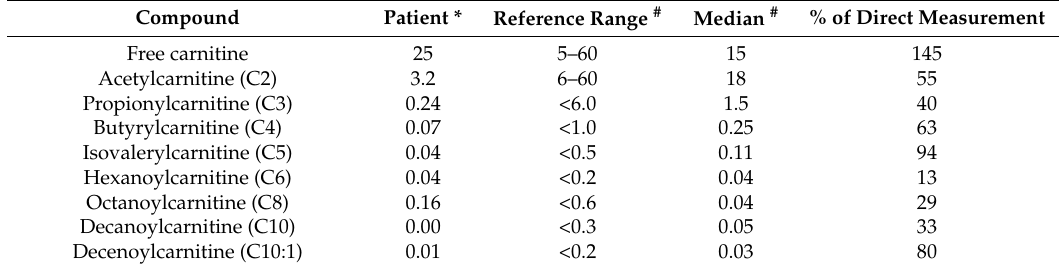
Table 1. Concentration of acylcarnitines from stored EDTA blood of the patient. (Concentrations in µ